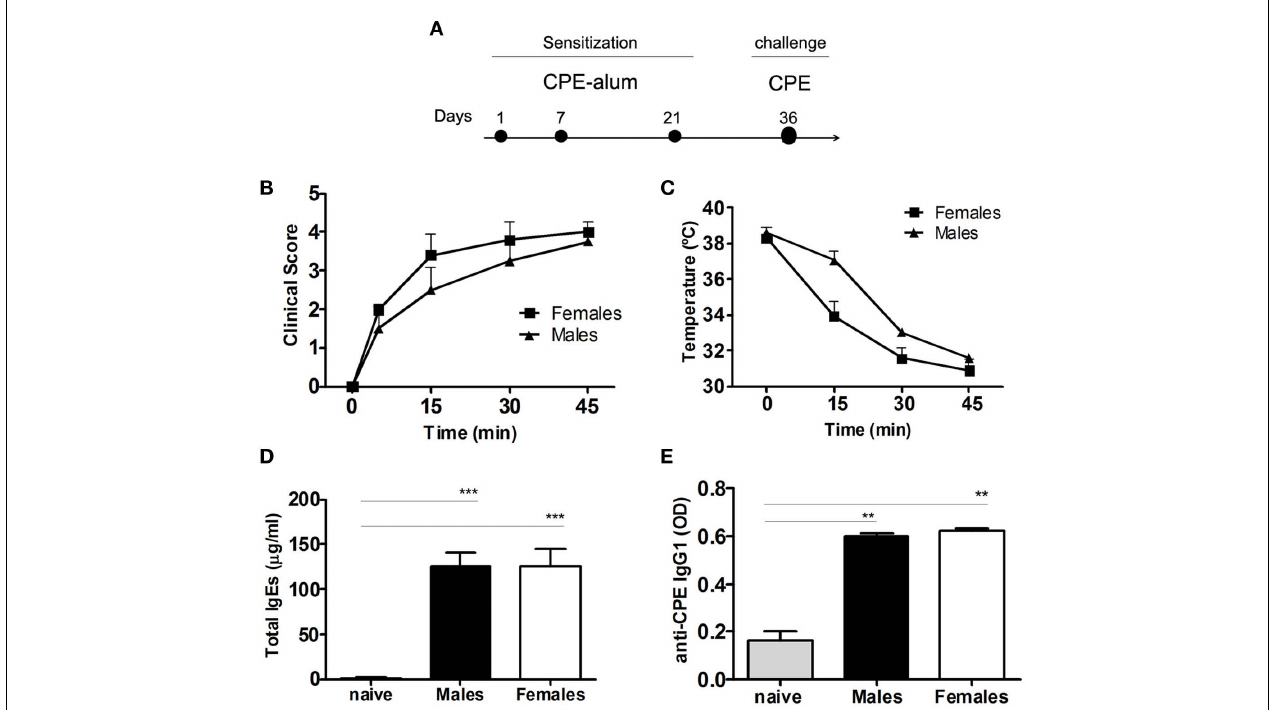
show more severe clinical manifestations of anaphylaxis, compared to male mice, but without reaching statistical significance. (D) Total IgE and (E) CPE-specific IgG1 were measured in the serum of individual mice. Both males and females showed an increase in the immunoglobulin levels compared to naïve mice ( n = 5, ** P < 0.01). Data (B–E) are representative of two independent